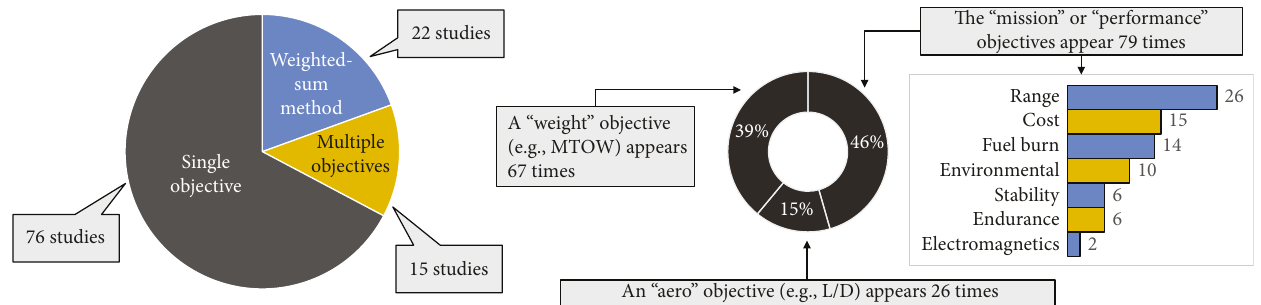
Figure 3: The reoccurrence rate of the di ff erent problem formulations (left) and types of objectives